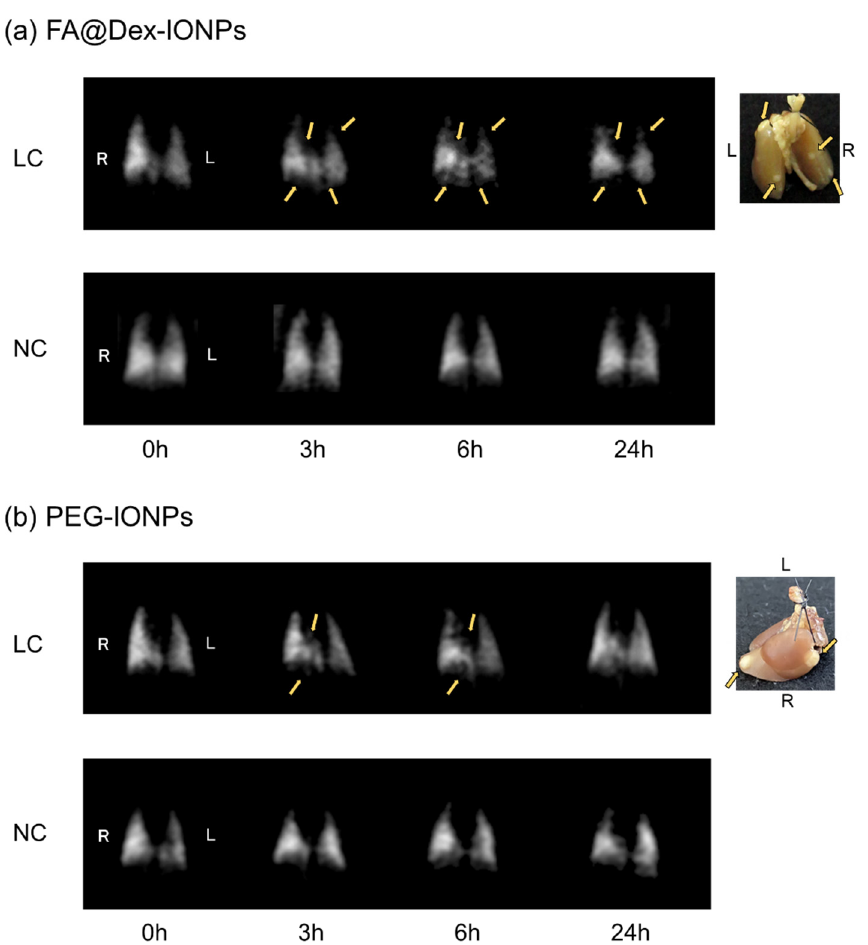
Figure 2. Representative examples of temporal changes of HP 129 Xe MRI lung images pre and post FA@Dex-IONPs and ( a ) PEG-IONPs ( b ) administration together with photographs of the lung. Arrows indicate the locations of lung cancer qualitatively determined from comparison of the images with photographs of lung. Note that the PEG-IONPs LC mouse is the same as that in Figure 1. R, right lung; L, left